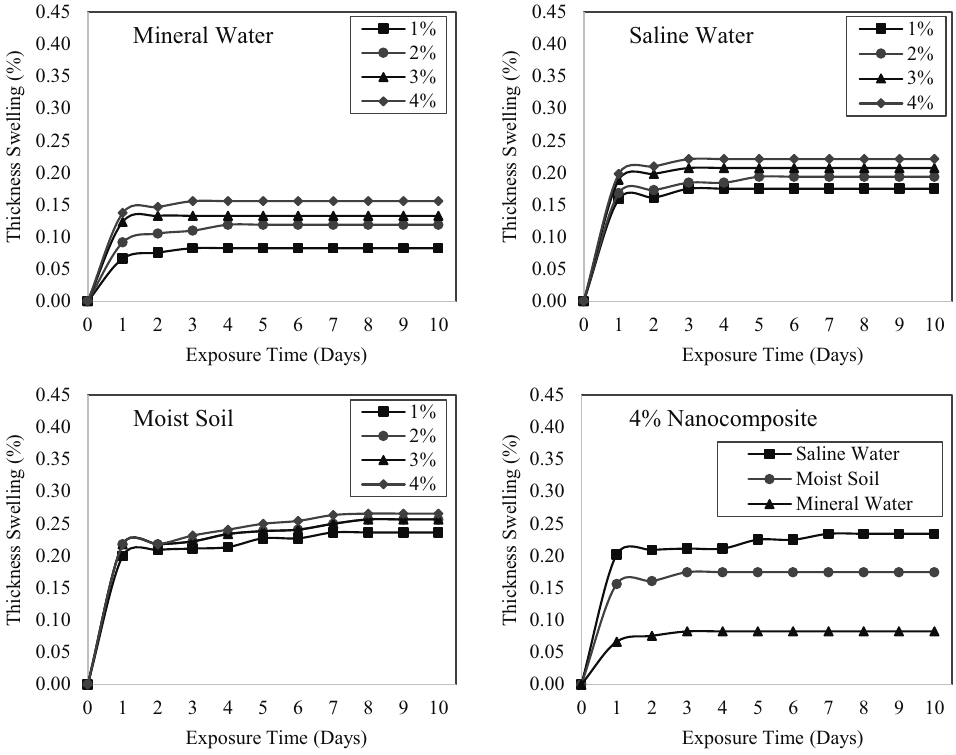
Figure 7: Thickness swelling of ES fi ller composites under di ff erent environmental conditions. Figures are produced based on the data in [ 11 ]